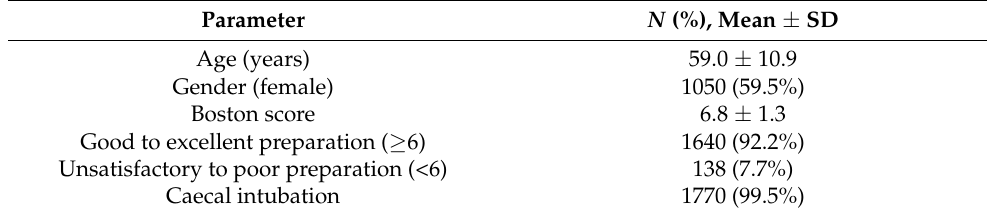
Table 1. Patient’s